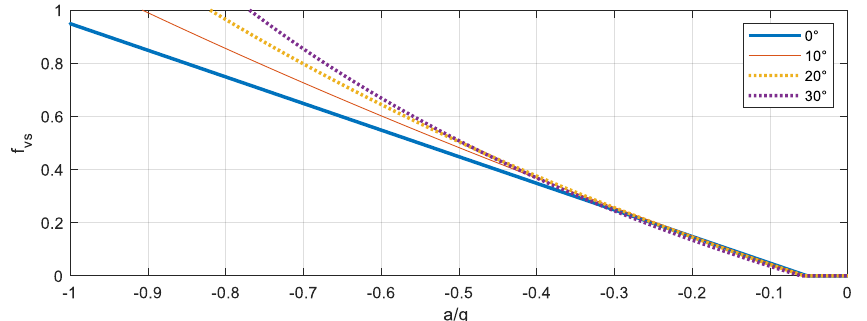
Figure 2. Static rolling friction coefficient that prevents the rolling motion, 𝜃 = 3° and parametric values of 𝜓 .